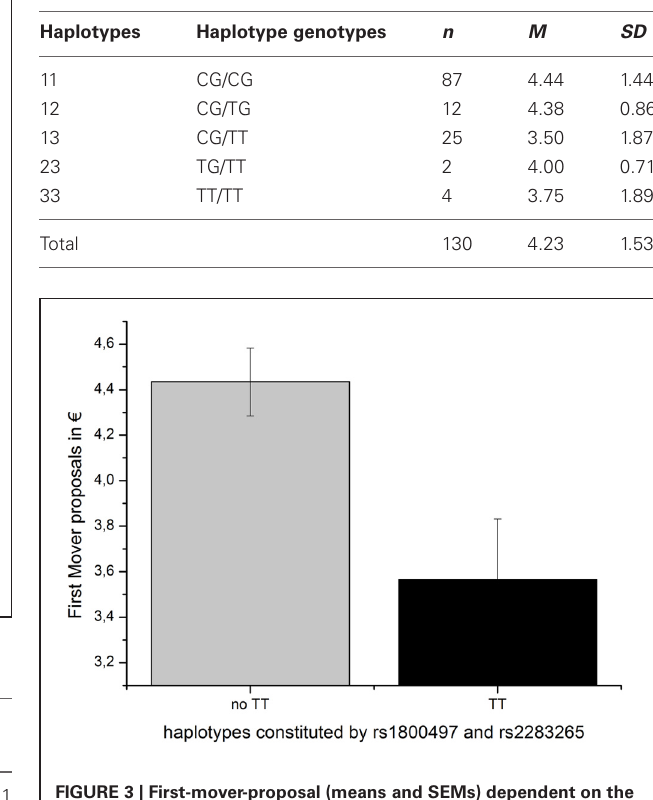
FIGURE 3 | First-mover-proposal (means and SEMs) dependent on the DRD2 ANKK1 haplotype consisting of the two SNPs rs1800497 and rs